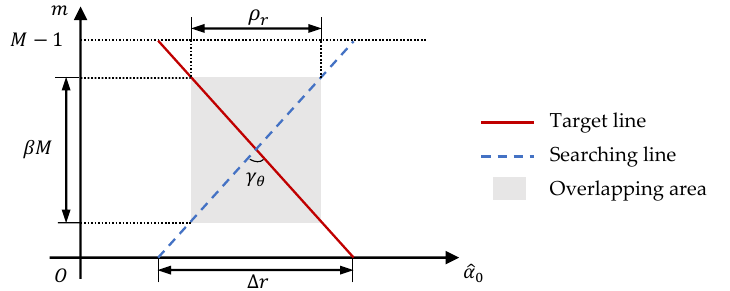
Figure 1. Sketch map of intersection limitation.